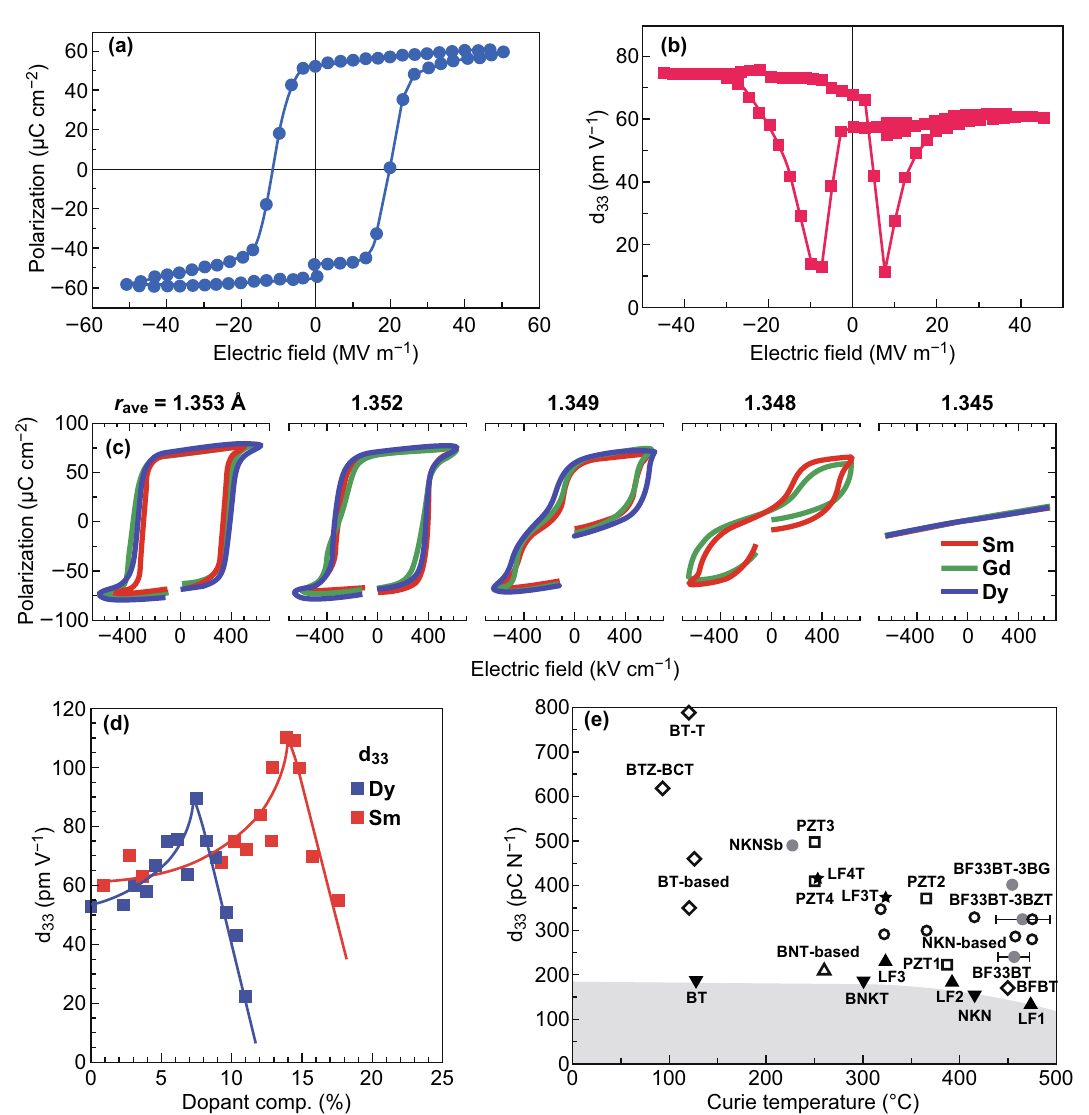
Fig. 3 Ferroelectric and piezoelectric properties of BFO nanomaterials. a , b A ferroelectric hysteresis loop and d 33 measured at an epitaxial BFO thin film. Adapted with permission from Ref. [7]. c Polarization hysteresis loop changes with the average A‑site ionic radius changed for rare earth‑substituted BFO thin films. Adapted with permission from Ref. [46]. d Piezoelectric coefficient d 33 for rare earth‑substituted BFO films. Applied Physics Letters Adapted with permission from Ref. [53]. e The piezoelectric properties of 0.67BF–0.33BT when a third ABO 3 compound was added. Adapted with permission from Ref.